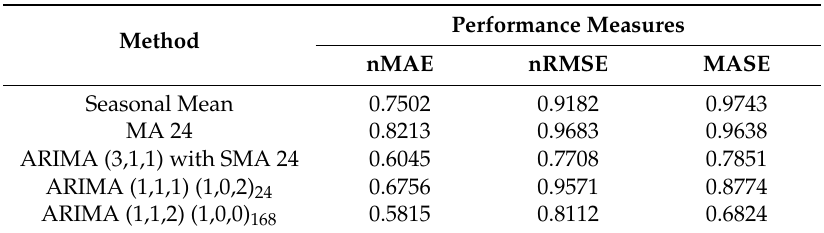
Table 2. Model Fitting Results for EWH Consumption.